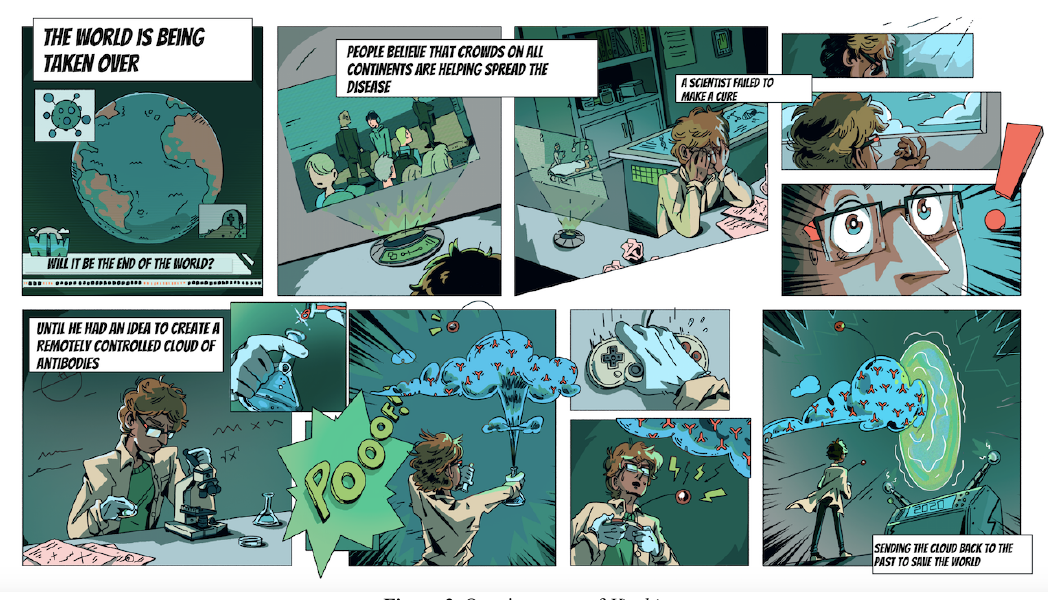
Figure 2. Opening scene of Viral.izo